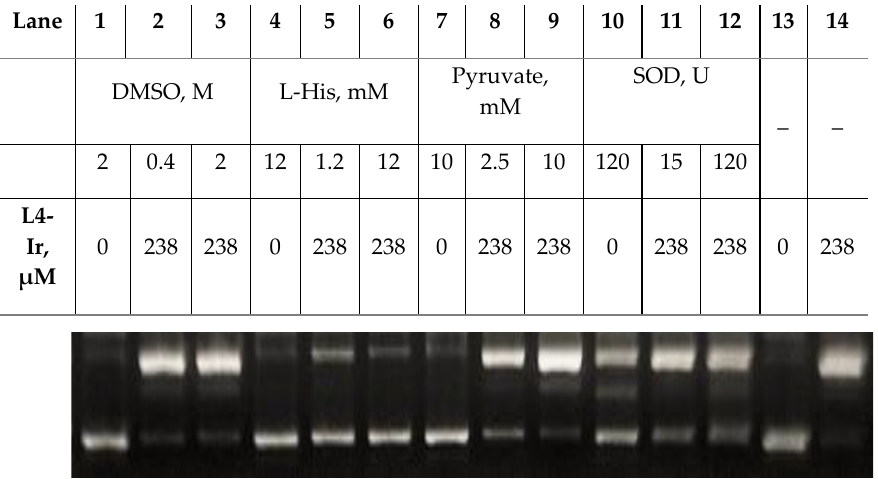
16 of 27 Figure 8. Electrophoresis mobility assay of pUC18 (20 µM) with DMSO (lane 2), cisplatin (lane 3), L4-Ru (lanes 4 – 6), L4-Rh (lanes 7 – 9), L4-Ir (lanes 10 – 12) and HL4 (lanes 13 – 15) at different C D /C P ratios. SC: supercoiled, OC: open circular and L: linear forms. Since only the iridium complex display DNA chemical nuclease activity, the under- lying mechanism was further investigated by means of a cleavage electrophoresis assay in which several well-known radical scavengers such as DMSO for OH · , L-histidine for 1 O 2 , sodium pyruvate for H 2 O 2 and superoxide dismutase (SOD) for O 2 − were included (Figure 9) [129]. Treatment of pUC18 with a high concentration of L4-Ir (lane 14) causes the vanishing of the SC form and an increase in the amount of the OC and L topologies. In the presence of different amounts of DMSO (lanes 2 and 3) or pyruvate (lanes 8 and 9), DNA cleavage is not inhibited, whereas SOD (lanes 11 and 12) seems to partially circum-